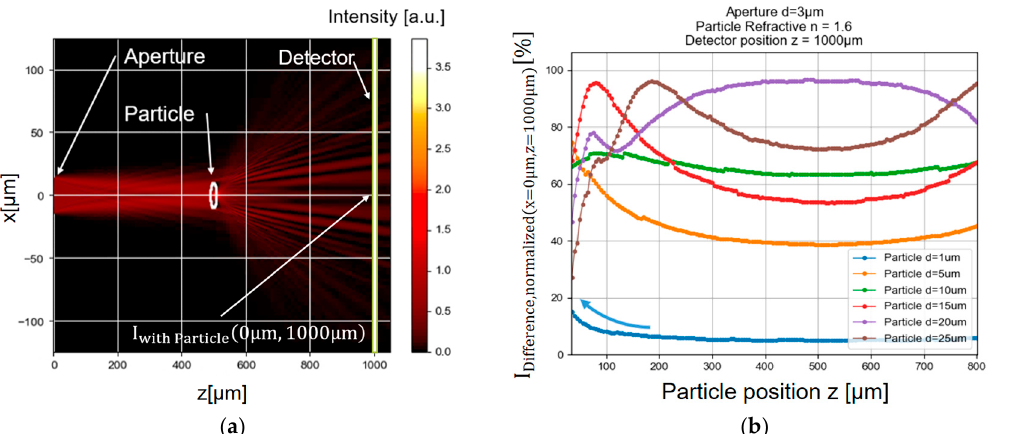
Figure 1. Simulation results of the particle detection setup: ( a ) the 2D intensity profile with a 30 µm aperture located at z equals zero, and the particle located at x equals zero with a distance of 500 µm between the particle and aperture; ( b ) normalized difference intensity over the distance between the particle and the 3 µm aperture. An increase in the normalized difference intensity and thus the detectability for the 1 µm particle can be observed for low distances, indicated by the blue